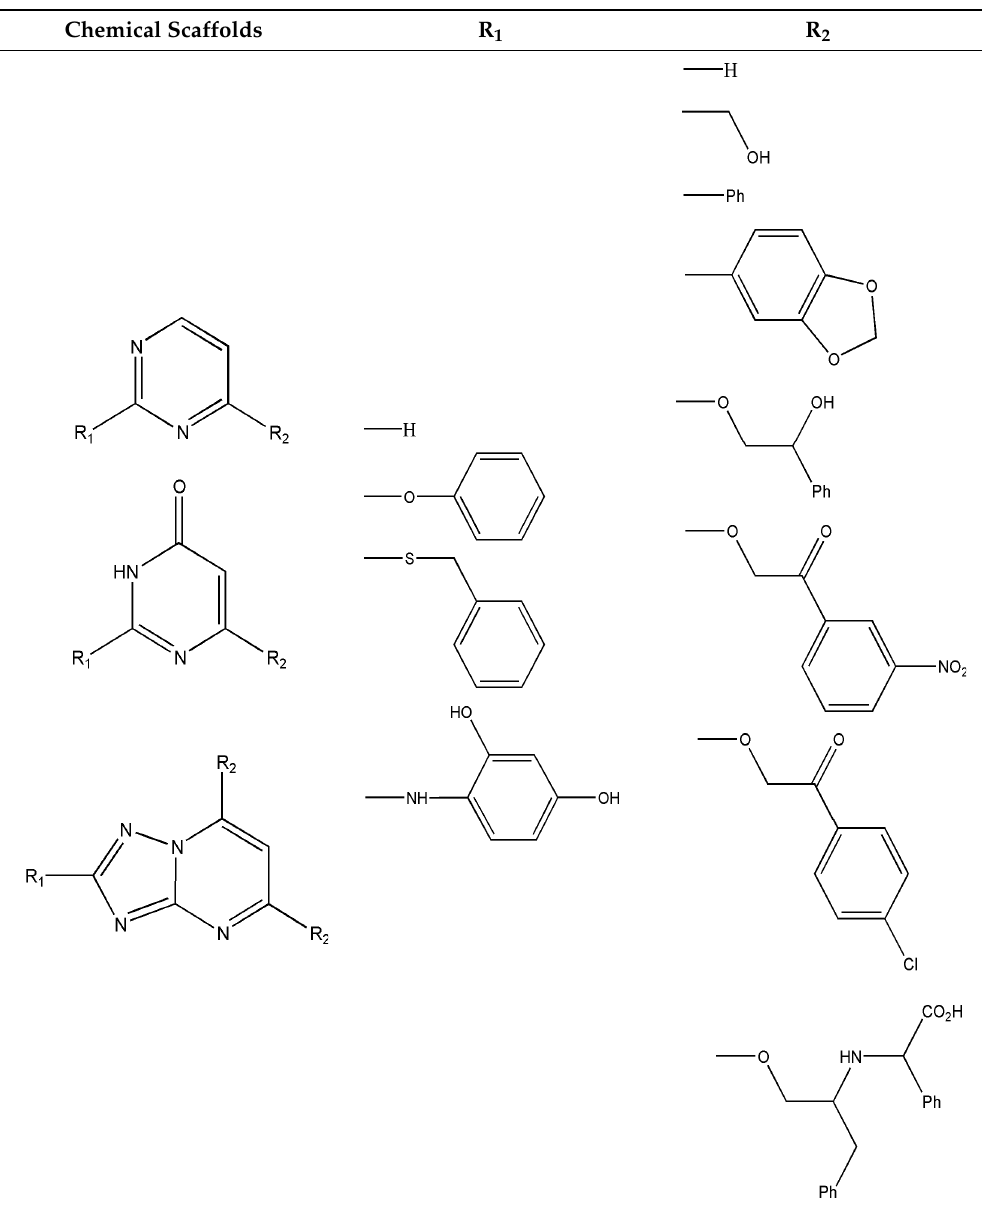
Table 5. Scaffolds and fragments used for the generation of the virtual library.